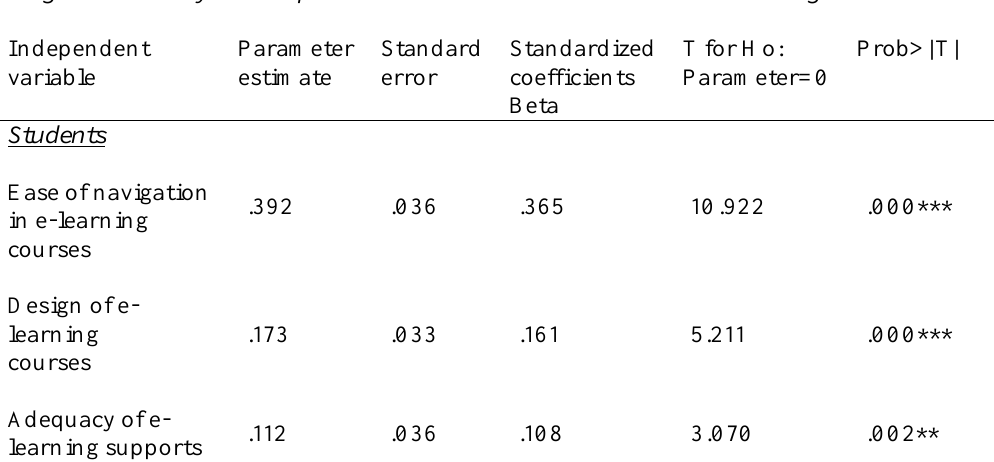
Regression Analysis – Dependent Variable: Enhanced Student Learning Independent variable